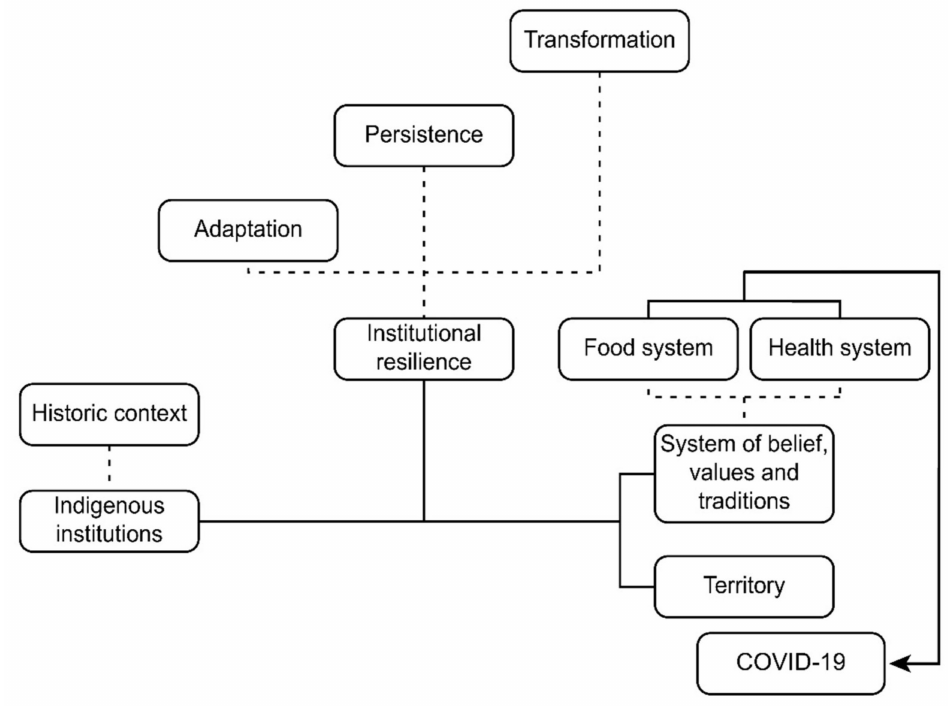
Figure 1. Theoretical model of the